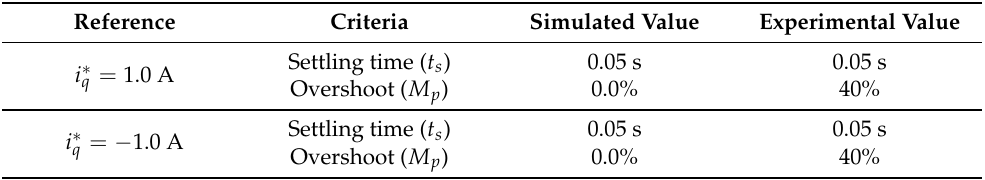
Table 7. Controller performance for reference i ∗ q = 1.0 A and i ∗ q = − 1.0 A.